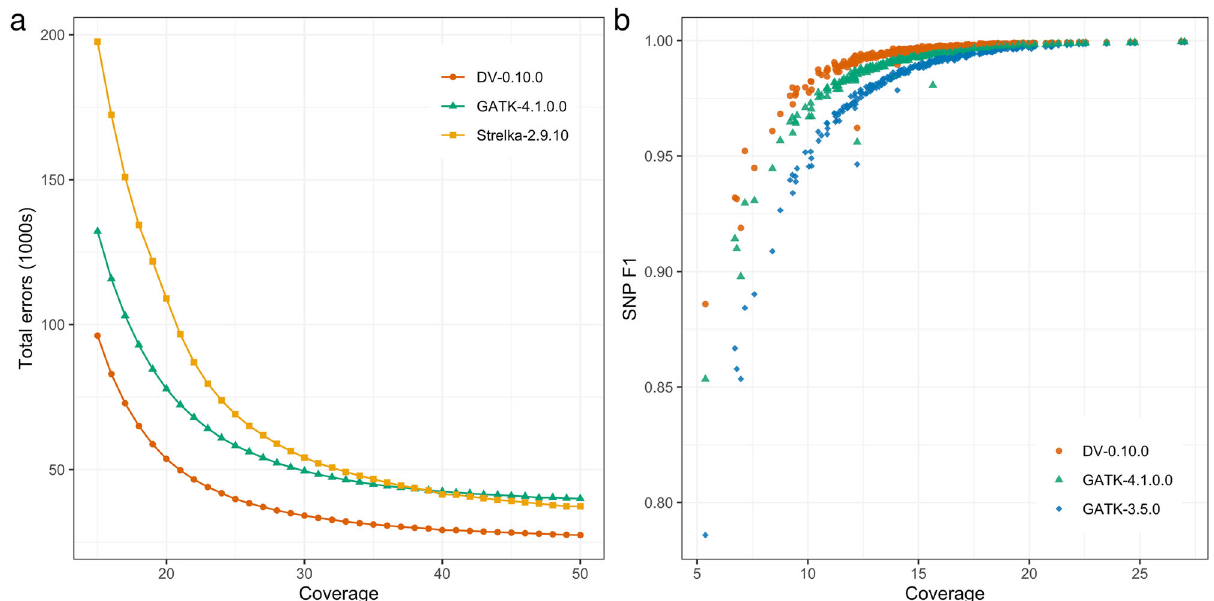
Fig. 2 Single-sample variant-calling accuracy as a function of sequence coverage. a Total errors (SNP + indel; lower is better) in HG002 in the Genome in a Bottle v4.1 truth regions as a function of sequence coverage for DeepVariant-0.10.0, GATK-4.1.0.0, and Strelka-2.9.10. b F1 metric (harmonic mean of precision and recall; higher is better) per sample for SNPs as a function of sequence coverage in a subset of 23andMe AFAM samples ( N = 292). Each sample produces three points at a single coverage level, indicating the F1 performance of that sample using each of the three variant callers. DeepVariant substantially outperforms both versions of GATK, in particular on lower coverage data.